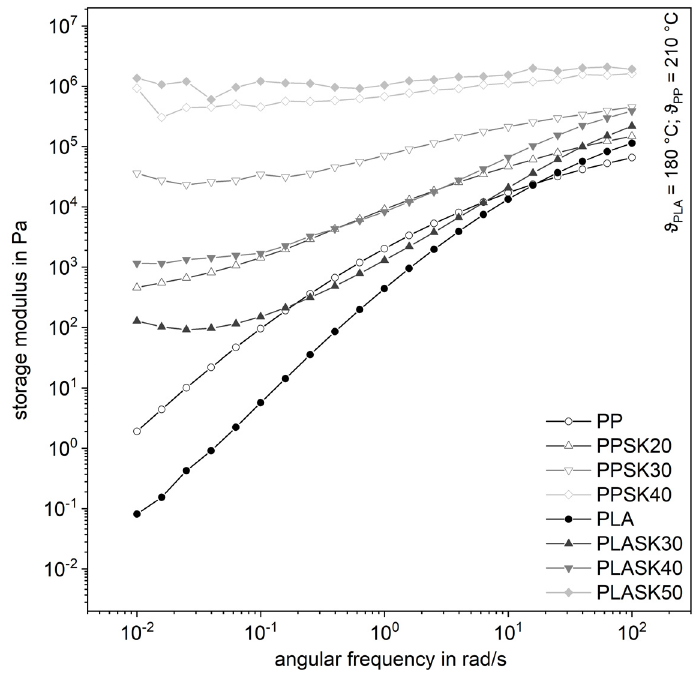
Figure 5. Influence of the plastic matrix on the storage modulus of the compounds for with the larger fused silica (SK) 223